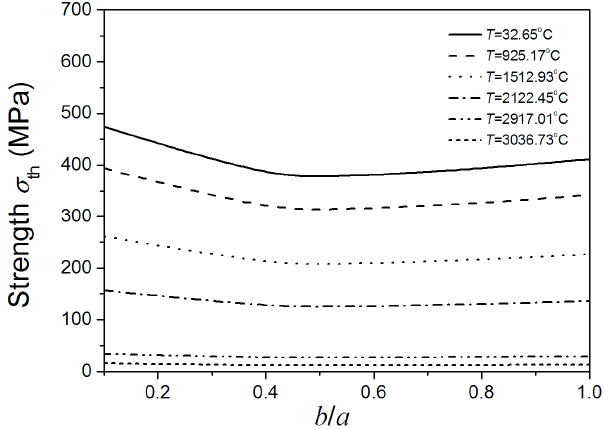
Figure 8. b / a ratio dependence of the material’s fracture strength on the same crack edge under different